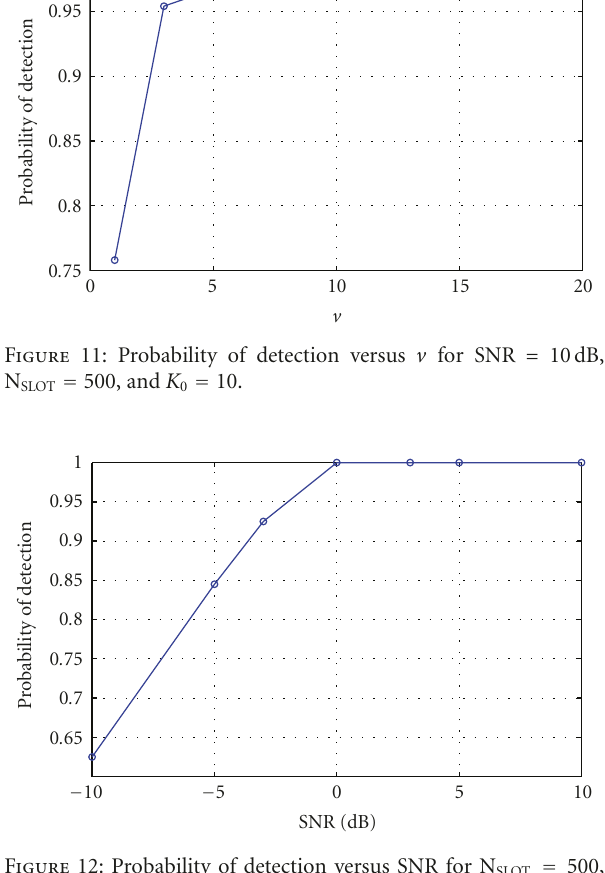
Figure 10: Probability of detection versus K 0 for v = 20m/s, SNR = 10dB, and N = 500. SLOT